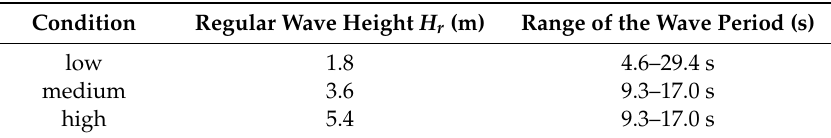
Table 6. Regular wave condition parameters in the full scale.